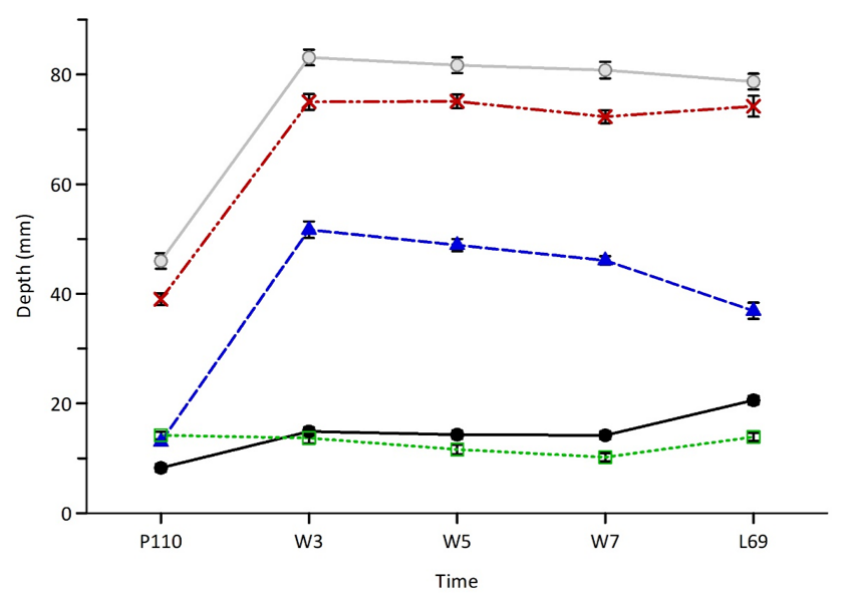
Figure 1. Average depths (±s.e.m.) of the mammary gland cistern (GC; black circles—solid line), mammary fat pad (FP; empty squares—green dotted line), mammary parenchyma (PAR; blue triangles—blue dashed line), total depth of the mammary gland conservative (MTc; red crosses—dashed and dotted line) and generous (MTg; grey circles—solid line) in late pregnancy (P110), lactation (W3, W5, W7) and at weaning (L69). Within lines, averages with different letters were significantly different ( p < 0.05).